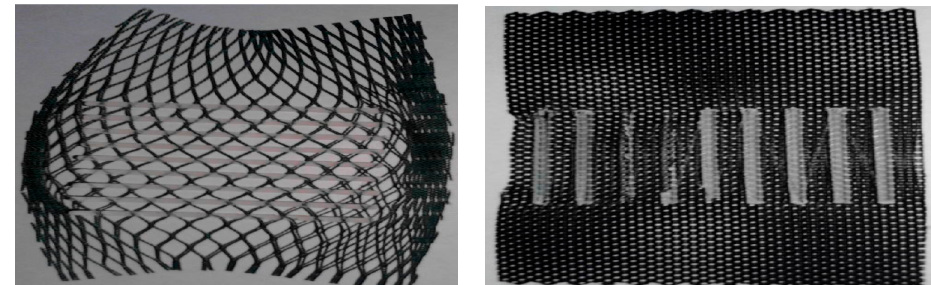
Figure 7. Polylactic acid (PLA) strips with different warp knitted mesh structures as inlays: fishing net produced from 100% polyamide 6 (left panel), and sunscreen net, by Karl Mayer, produced from 100% polyester (right panel) [65]